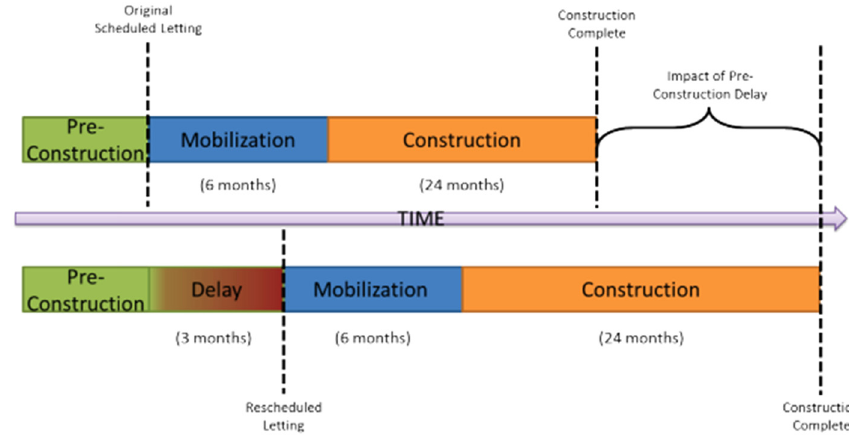
Figure 1: Preconstruction delays impact the completion of construction [ 1 ]